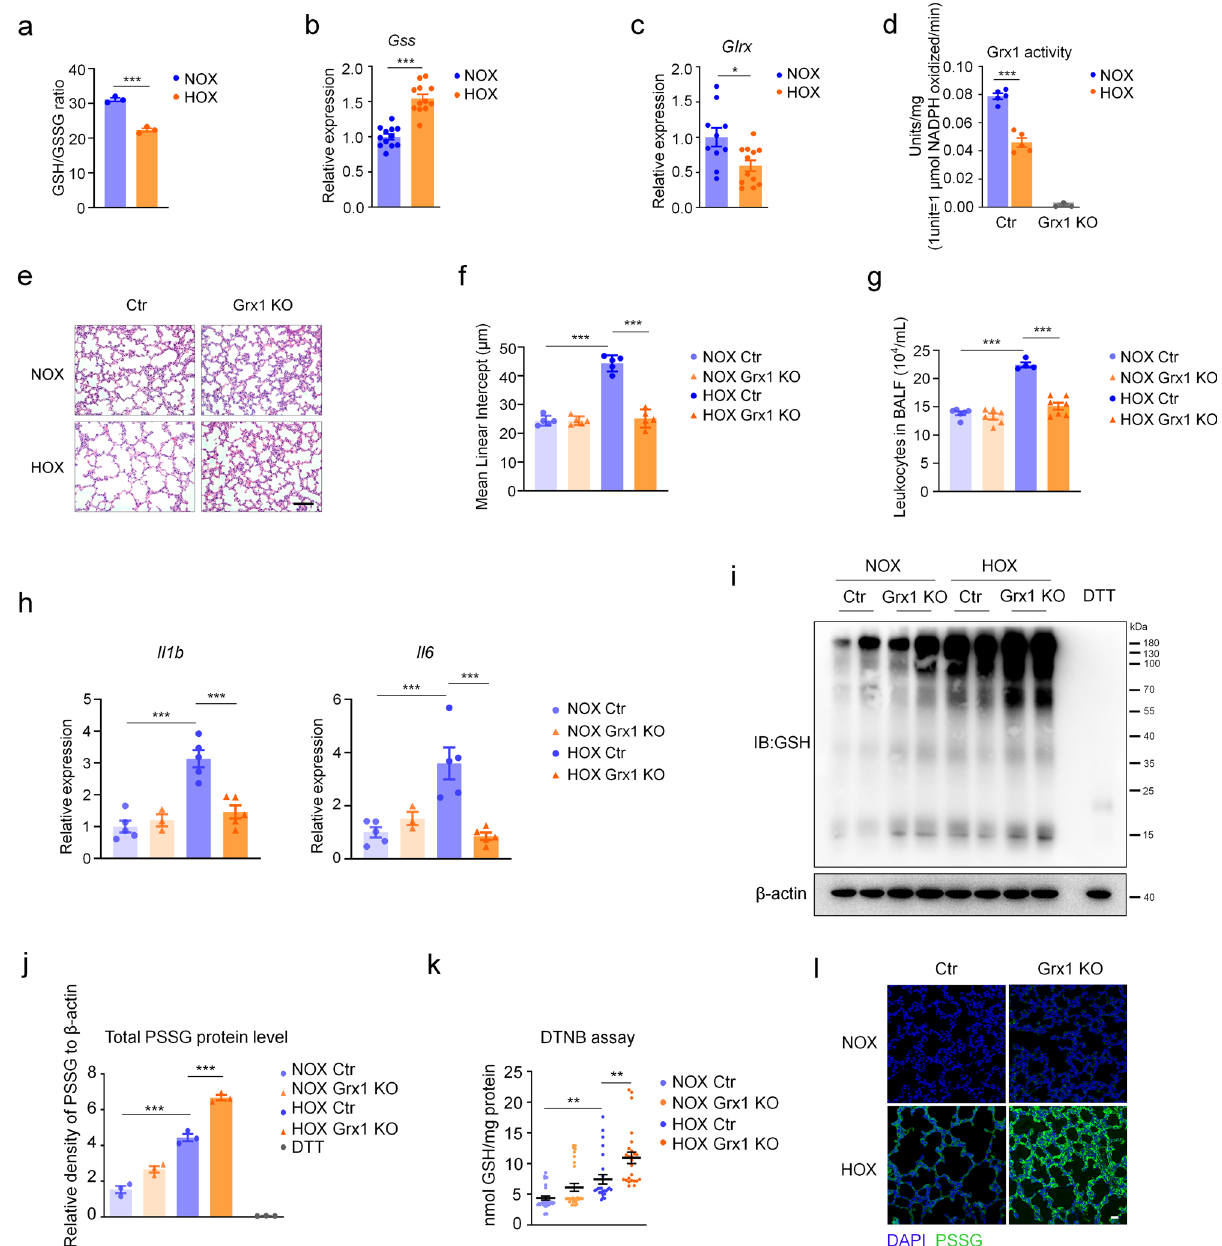
Fig. 1 Grx1-regulated protein S-glutathionylation alleviates hyperoxia-induced acute lung injury. a GSH/GSSG ratio in BALF from mice exposed to NOX ( n = 3) or HOX ( n = 3), P = 0.0003. b mRNA levels of Gss in lung tissue harvested after exposure to NOX ( n = 12) or HOX ( n = 12) as determined by qPCR, P < 0.0001. c Glrx mRNA expression in lung tissue from mice exposed to NOX ( n = 10) or HOX ( n = 12), P = 0.0125. d Grx1 activity (reaction mixtures containing L-CySSG) in lung tissue after exposure to NOX ( n = 5) or HOX ( n = 5), negative control (Grx1 KO mice, n = 3), P (NOX ctr vs. HOX ctr) <0.0001. e H&E staining of mice lungs exposed to NOX or HOX (scale bars, 100 μ m). f Morphometric analyses of lung by mean linear intercept (MLI) in all groups as in ( e ), n = 5 in each group, *** P < 0.0001. g Total numbers of leukocytes in BALF from mice exposed to NOX or HOX, n = 6, 6, 4, 7, respectively, *** P < 0.0001. h mRNA levels of Il1b and Il6 in lung tissue from mice exposed to NOX or HOX as determined by qPCR, n = 5, 3, 5, 5, respectively, P ( Il1b , NOX ctr vs. HOX ctr) < 0.0001, P ( Il1b , HOX ctr vs. HOX Grx1 KO) = 0.0004, P ( Il6 , NOX ctr vs. HOX ctr) = 0.0007, P ( Il6 , HOX ctr vs. HOX Grx1 KO) = 0.0004. i Protein S-glutathionylation in lung tissue from mice exposed to NOX or HOX via non-reducing Western blot (DTT, negative control; β -actin, loading control). j Relative expression of protein S-glutathionylation in lung tissue as in ( i ). Optical density is normalized by β -actin, n = 3 in each group, ***P < 0.0001. k Protein S-glutathionylation quanti fi ed by DTNB assay in lung tissue from mice exposed to NOX or HOX (data shown in nmol GSH/mg protein), n = 35, 30, 25, 25, respectively, P (NOX ctr vs. HOX ctr) = 0.0065, P (HOX ctr vs. HOX Grx1 KO) = 0.0029. l Lung tissue sections from mice exposed to NOX or HOX stained for S-glutathionylated proteins (green). DAPI (blue), Scale bars, 20 μ m. All samples were biologically independent and three or more independent experiments were performed. All quantitative data are shown as mean ± SEM and analyzed with a 95% con fi dence interval. Two-tailed unpaired Student ’ s t test for ( a – c ); one-way ANOVA followed by Tukey ’ s post-hoc test for ( d , f , g , h , j , k ). * P < 0.05, ** P < 0.01, *** P < 0.001. Source data are provided as a Source Data fi le.